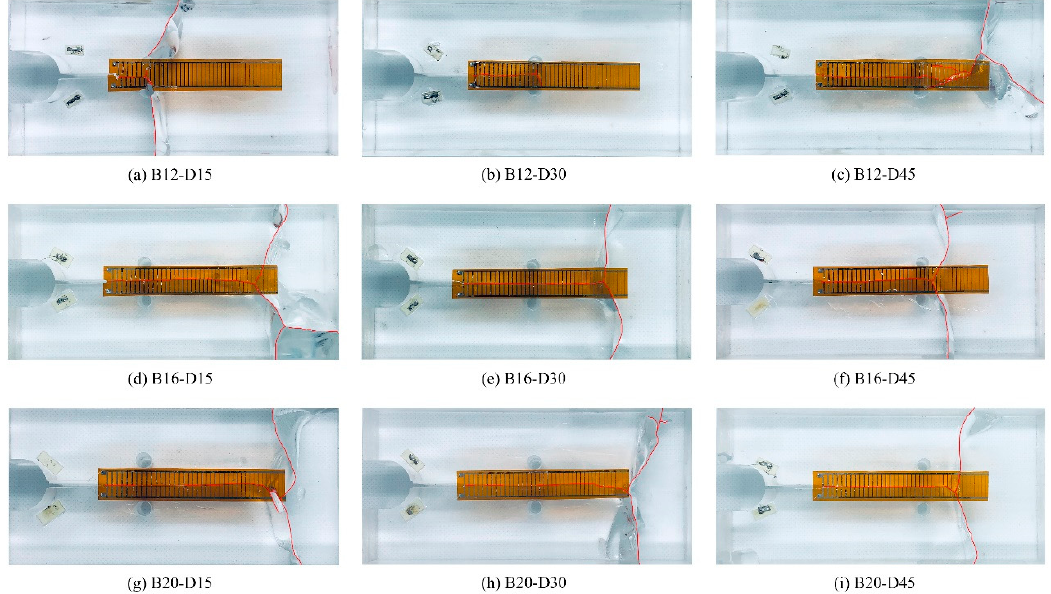
Figure 5. Crack fracture patterns of the specimens. ( a ) Crack pattern of the B12-D15 specimen. ( b ) Crack pattern of the B12-D30 specimen. ( c ) Crack pattern of the B12-D45 specimen. ( d ) Crack pattern of the B16-D15 specimen. ( e ) Crack pattern of the B16-D30 specimen. ( f ) Crack pattern of the B16-D45 specimen. ( g ) Crack pattern of the B20-D15 specimen. ( h ) Crack pattern of the B20-D30 specimen. ( i ) Crack pattern of the B20-D45 specimen.